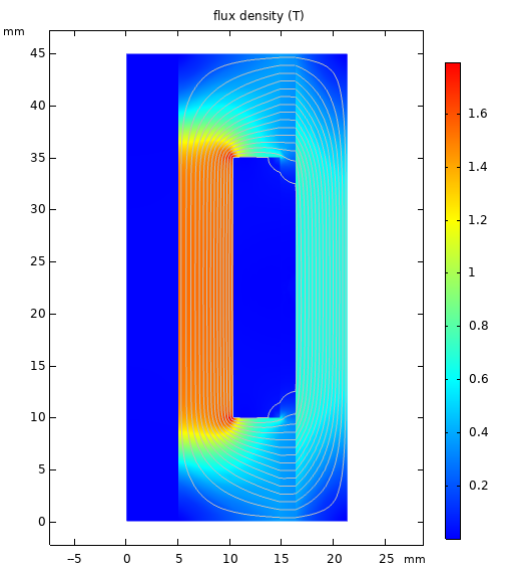
Figure 7. Magnetic flux density and magnetic line distribution at 2 A.